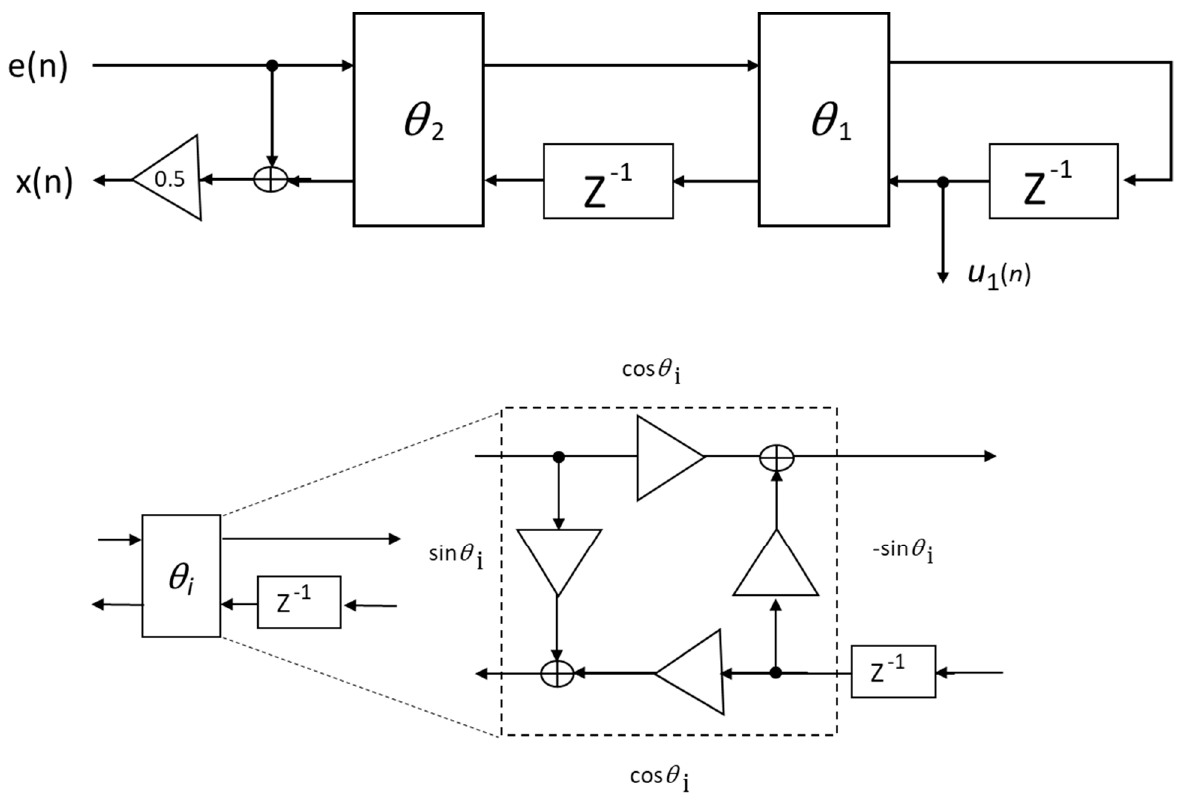
Figure 8. Block diagram of the adaptive notch filter in use.